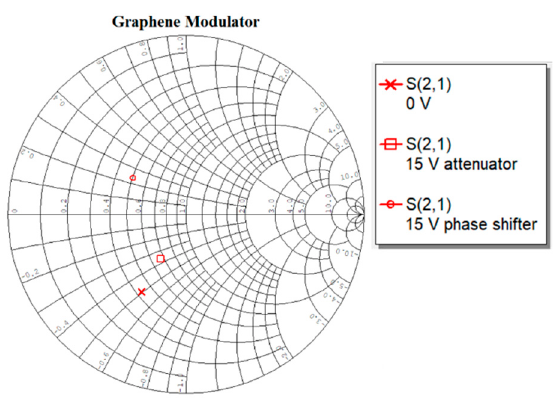
Figure 11. The maximum points of amplitude and phase variation shown on a smith chart.